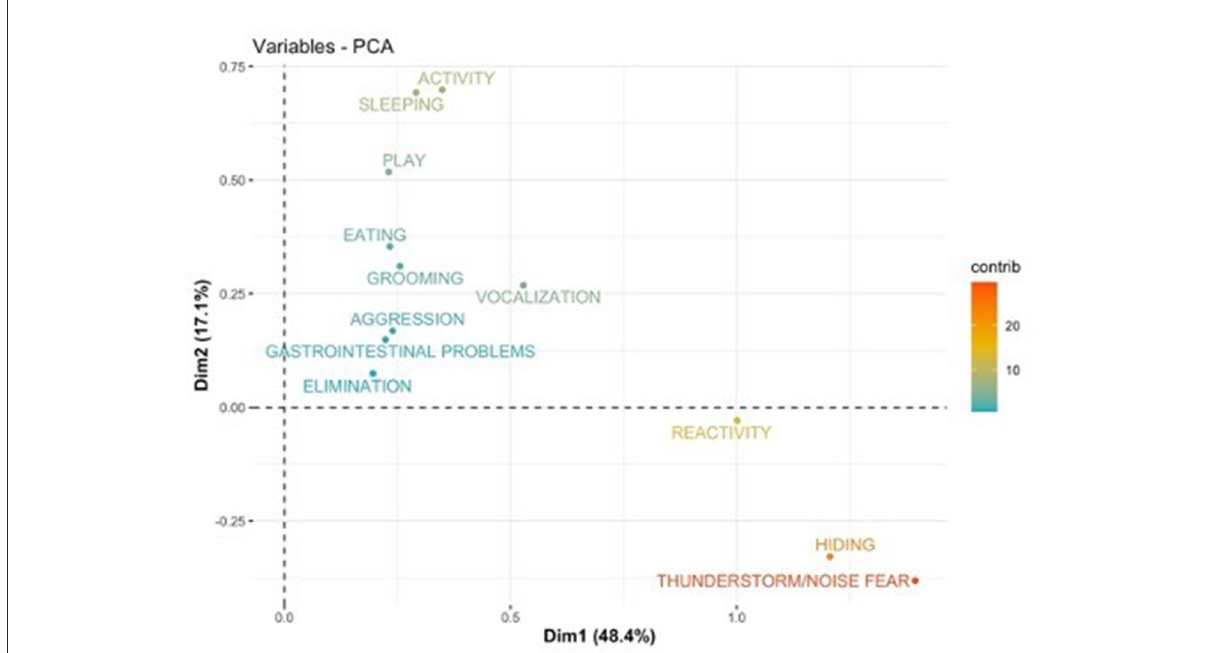
FIGURE4 Loadings plot of the behavioral variables of dogs on the first (PC 1) and second (PC 2) principal components with the increase of thunderstorms. The contribution of the variables is colored depending on their importance.